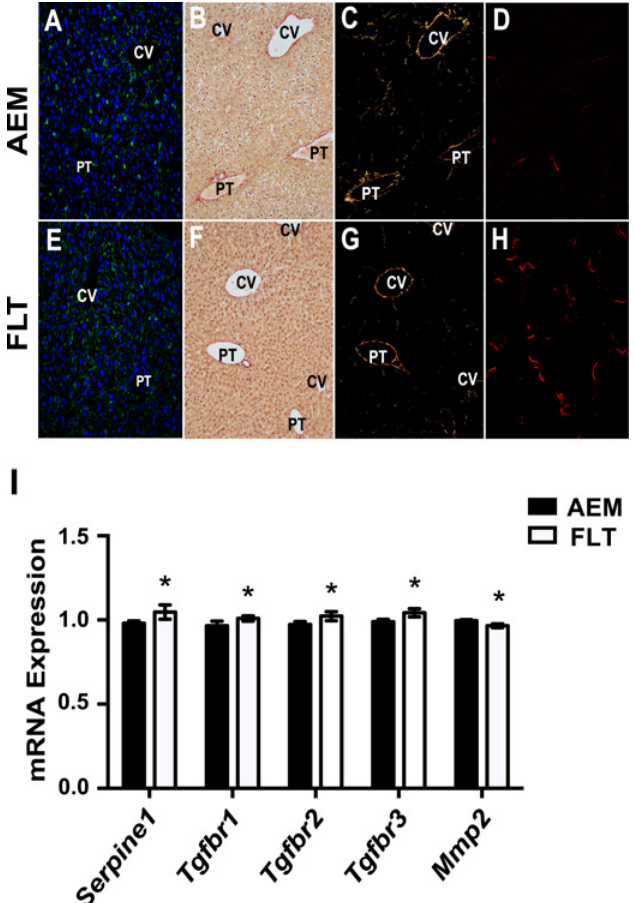
Fig 3. Lipid droplets in spaceflight mouse liver have reduced retinol content. Stimulated Raman scattering (SRS) images of liver sections (left panel) revealed a decreased intensity of embedded lipid droplets at ~1593 cm -1 for spaceflight mice (FLT, C ) with respect to ground mice (AEM, A ), and showed no difference at 2845 cm -1 ( B , D ), the C-H 2 symmetric stretching band characteristic of lipids. Hyperspectral SRS imaging (right panel) around the two frequencies of interest unveil quasi-identical spectra of the lipid droplets of the two mouse groups, except for the peak at ~1593 cm -1 (red curves). Spontaneous Raman spectra (black curves) agree with the SRS results. Raman spectra were acquired using n = 3 mice per group, 2 sections per mouse, and 2 – 3 droplets per section. Technical replicates were also performed for several samples. SRS imaging was used to confirm the Raman results and was performed on sections from one mouse in each